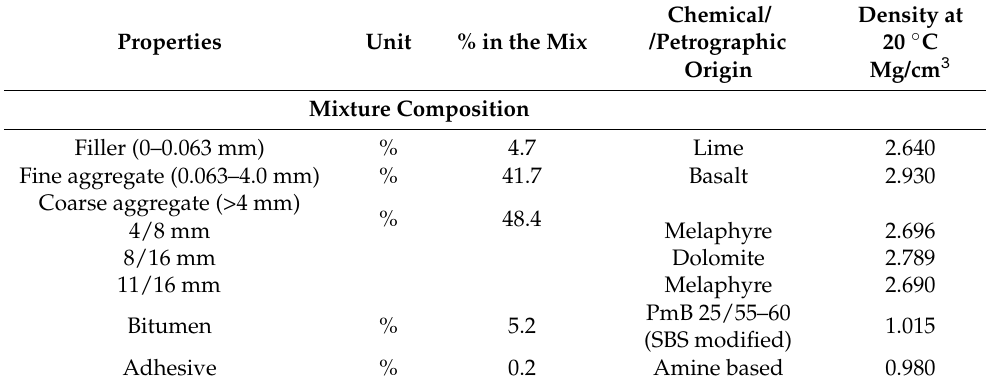
Table 1. Composition and chemical and petrographic origin of used materials.